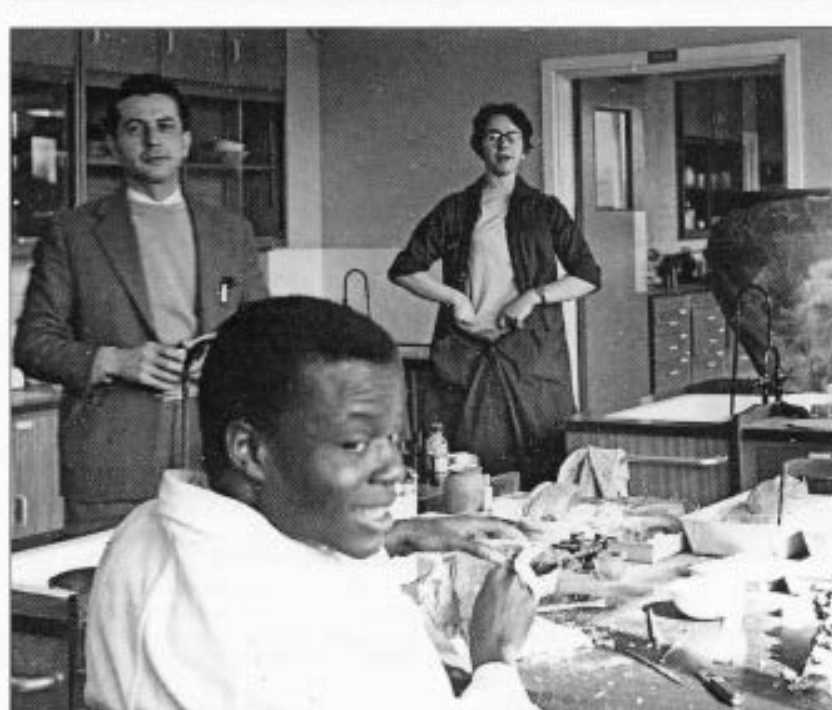
Figure 2 The new conservation laboratory at the Institute in Cordon Square in 1958. Then, as now, it attracted students from overseas; from left to right: Litko Zoll-Adanic (Poland}, Ben Brobby (Ghana) and Babin Deilakis (Greece).